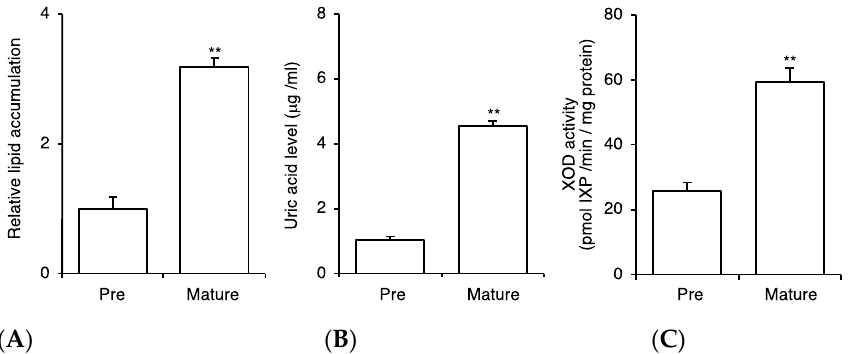
Figure 1. Comparison of adipogenesis and uric acid production from 3T3-L1 cells between the stages of preadipocytes and matured adipocytes. Data are means ± SE for 3 independent experiments. Asterisks indicate significant differences compared to the preadipocytes (pre) at p < 0.01, as evaluated by Student’s t-test. ( A ): Lipid accumulation evaluated by Oil Red O staining. ( B , C ): Uric acid release into media and cellular XOD activity.